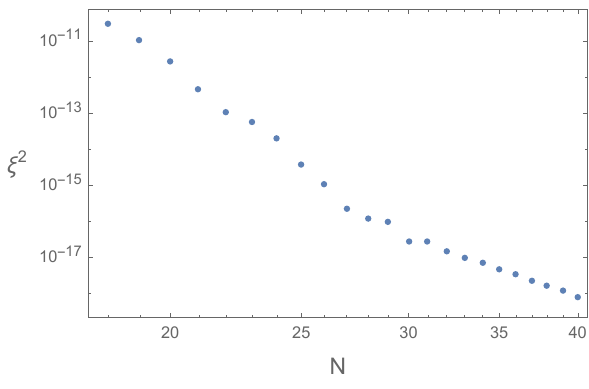
Figure 16 . (cid:24) 2 as a function of N z = N x = N for T = 0 : 01426 and k = 1 with (cid:22) = 1. We consider the same parameters as in (cid:12)gure 4.